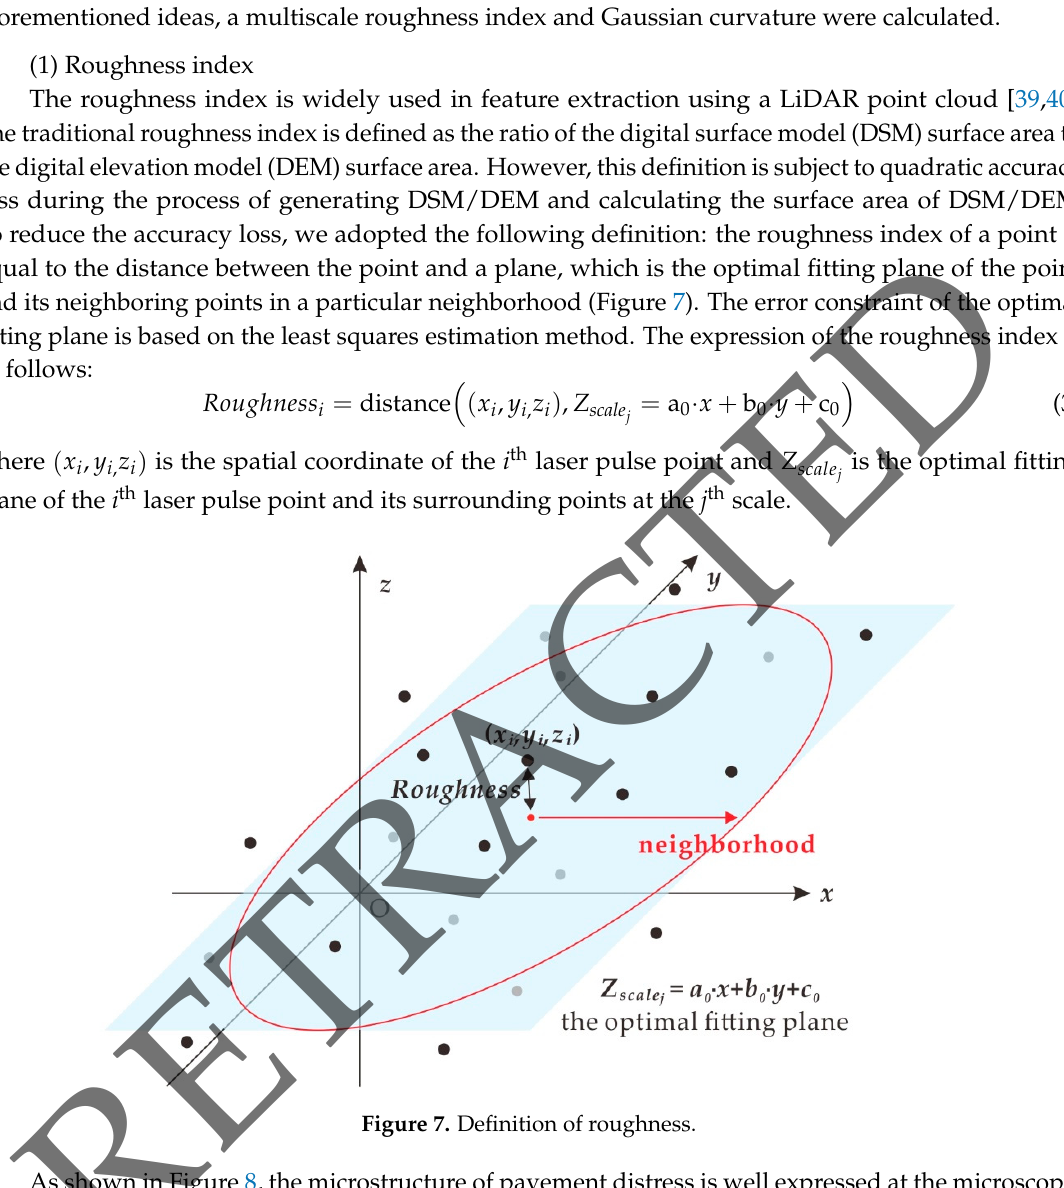
Table 2. Different measurement scales.